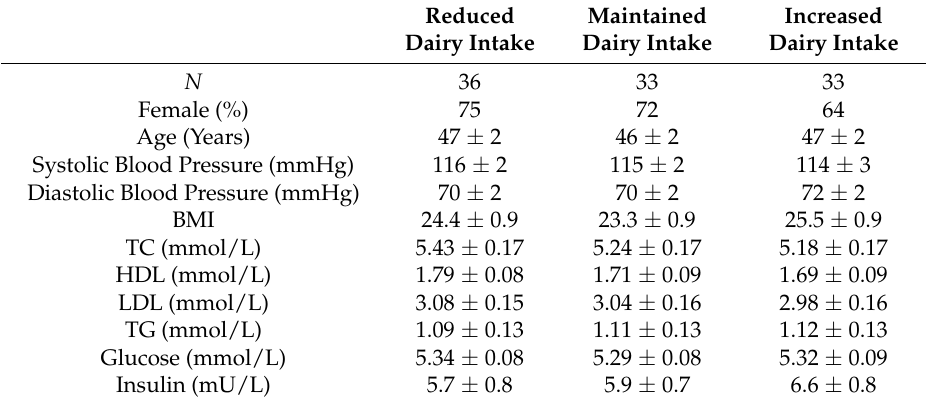
Table 1. Baseline subject characteristics.